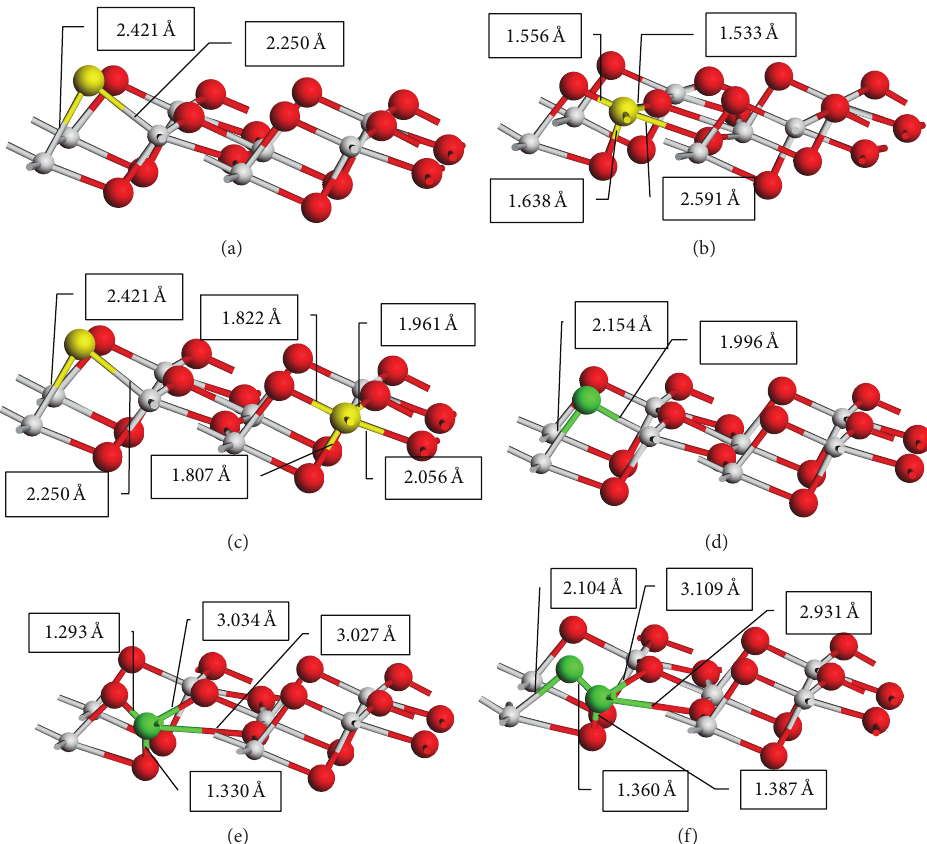
Figure 2: Relaxed structure of the first layer of S/C-doped surfaces: (a) Ti 24 O 47 S(A-STO), (b) Ti 23 SO 48 (C-STO), (c) Ti 23 SO 47 S(AC-STO), (d) Ti 24 O 47 C(A-CTO), (e) Ti 23 CO 48 (C-CTO), and (f) Ti 23 CO 47 C(AC-CTO). The bond length of S or C dopants with its neighboring Ti or O atoms is labeled. Ti and O atoms are represented by grey and red black spheres, respectively. Substitutional S and C dopants are represented by yellow and green